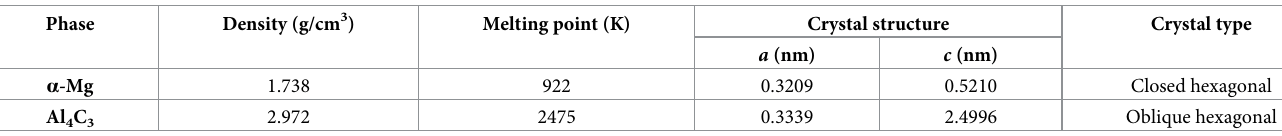
Table 3. Physical properties of Mg and Al 4 C 3